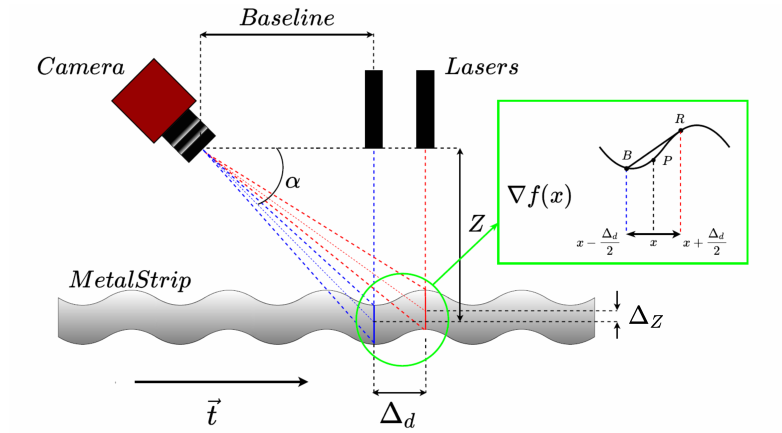
Figure 3. Design of the laser-camera sensor featuring two parallel laser lines allowing the computation of surface height and its gradient. The color of the representation is not related to the actual laser color, which is the same for both laser sources.